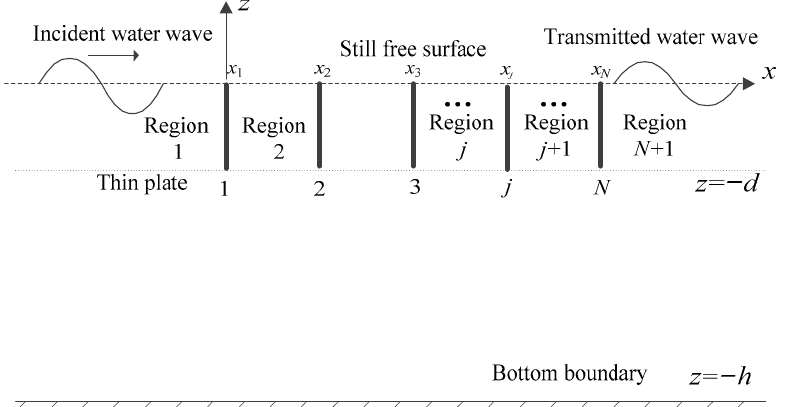
Figure 1. Schematic diagram of multiple vertical rigid plates.